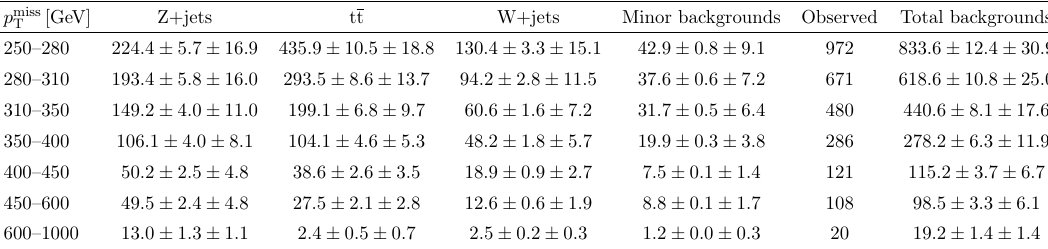
Table 4 . Predicted SM backgrounds and yields in data in each bin of the tight signal region, after performing the (cid:12)t in the control regions only. \Minor backgrounds" refers to the diboson, single t, and QCD multijet backgrounds. The uncertainties are reported as statistical (driven by the data in the CRs), followed by systematic.